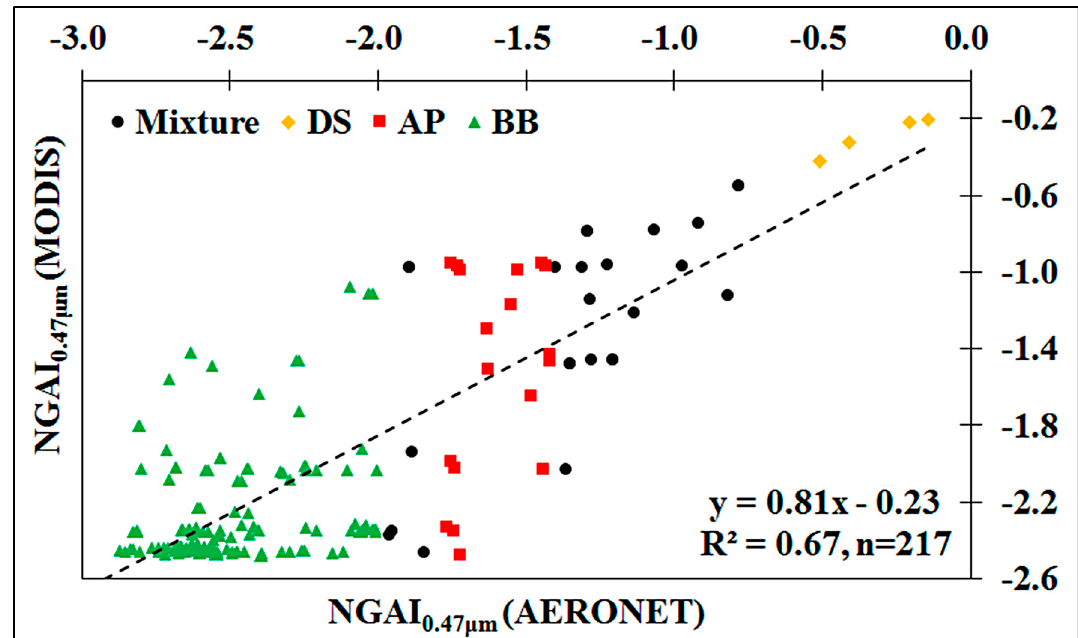
Figure A3. The comparison of aerosol categorization (217 cases) in terms of NGAI 0.47 μ m approach between MODIS AOD and ground-based measurement (AERONET) from January 2015 to March 2017. The colors in green, red, yellow and black represent BB, AP, DS and mixture aerosols respectively.